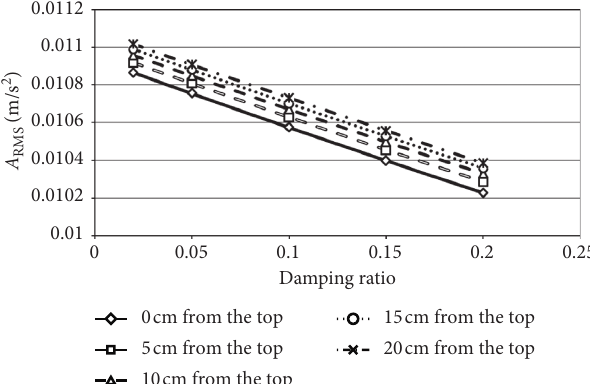
Figure 8: The effects of the damping ratio on vibration reduction (at monitored point E; damping layer thickness �